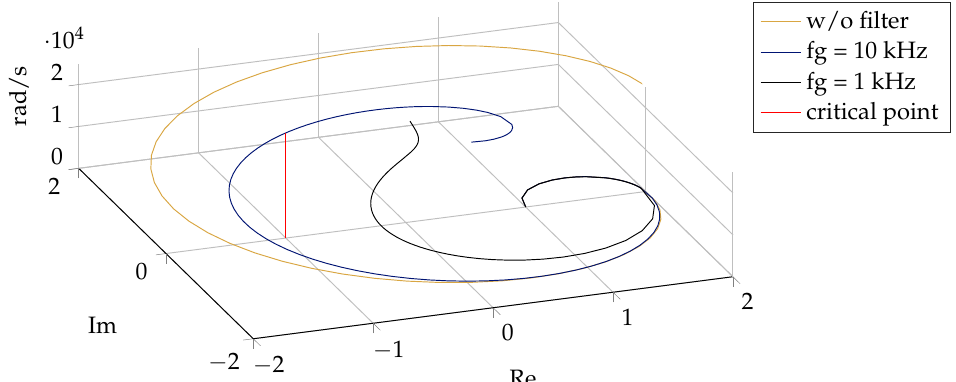
Figure 11. Locus plot of FSF-ITM with different cut-off frequencies with the angular frequency as an additional dimension.